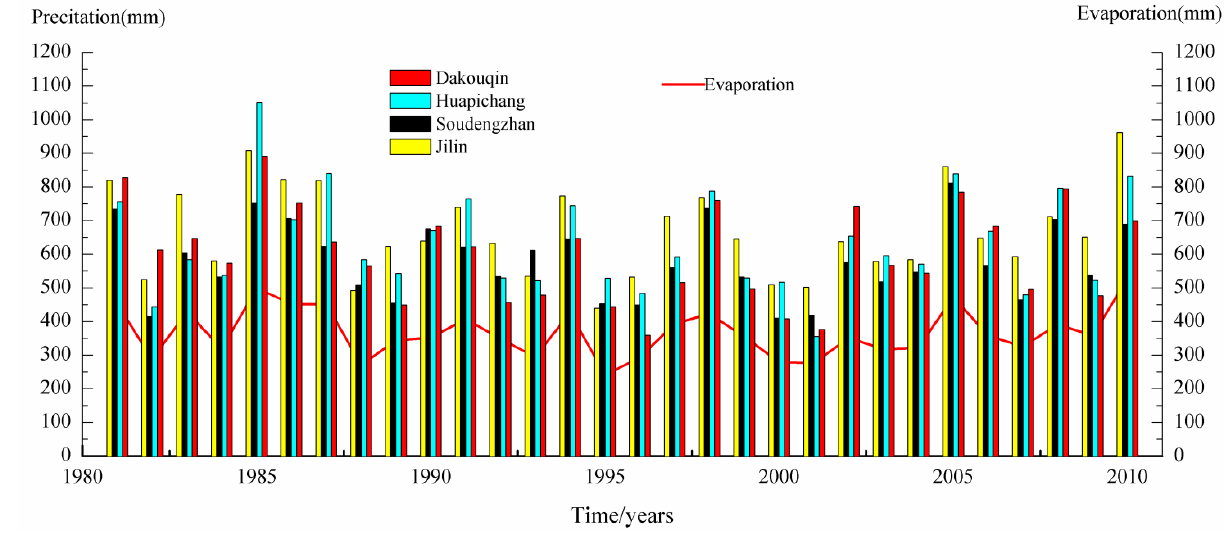
Figure 3. Annual precipitation and evaporation of the study area for the last 30 years.